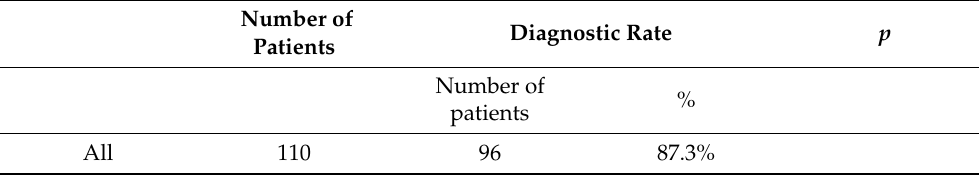
Table 3. Diagnostic rate by CT-GNB in relation to distance measurements and location of